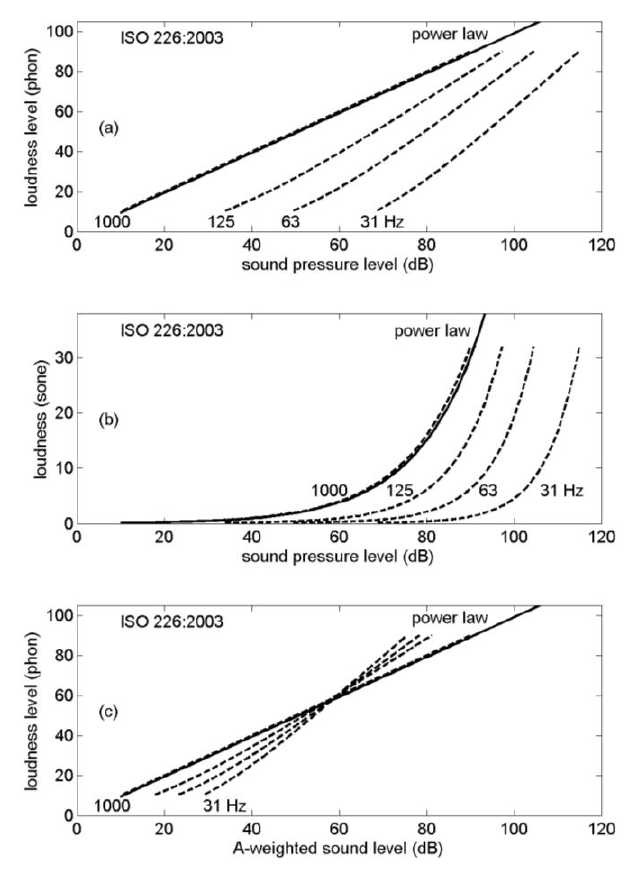
Figure 3. Loudness level (a) and loudness (b) as a function of sound pressure level, and loudness level as a function of A-weighted sound level (c) , for pure tones with frequencies 1000, 125, 63, and 31 Hz, according to ISO 226:2003 (dashed lines), and the 0.3 power law (solid